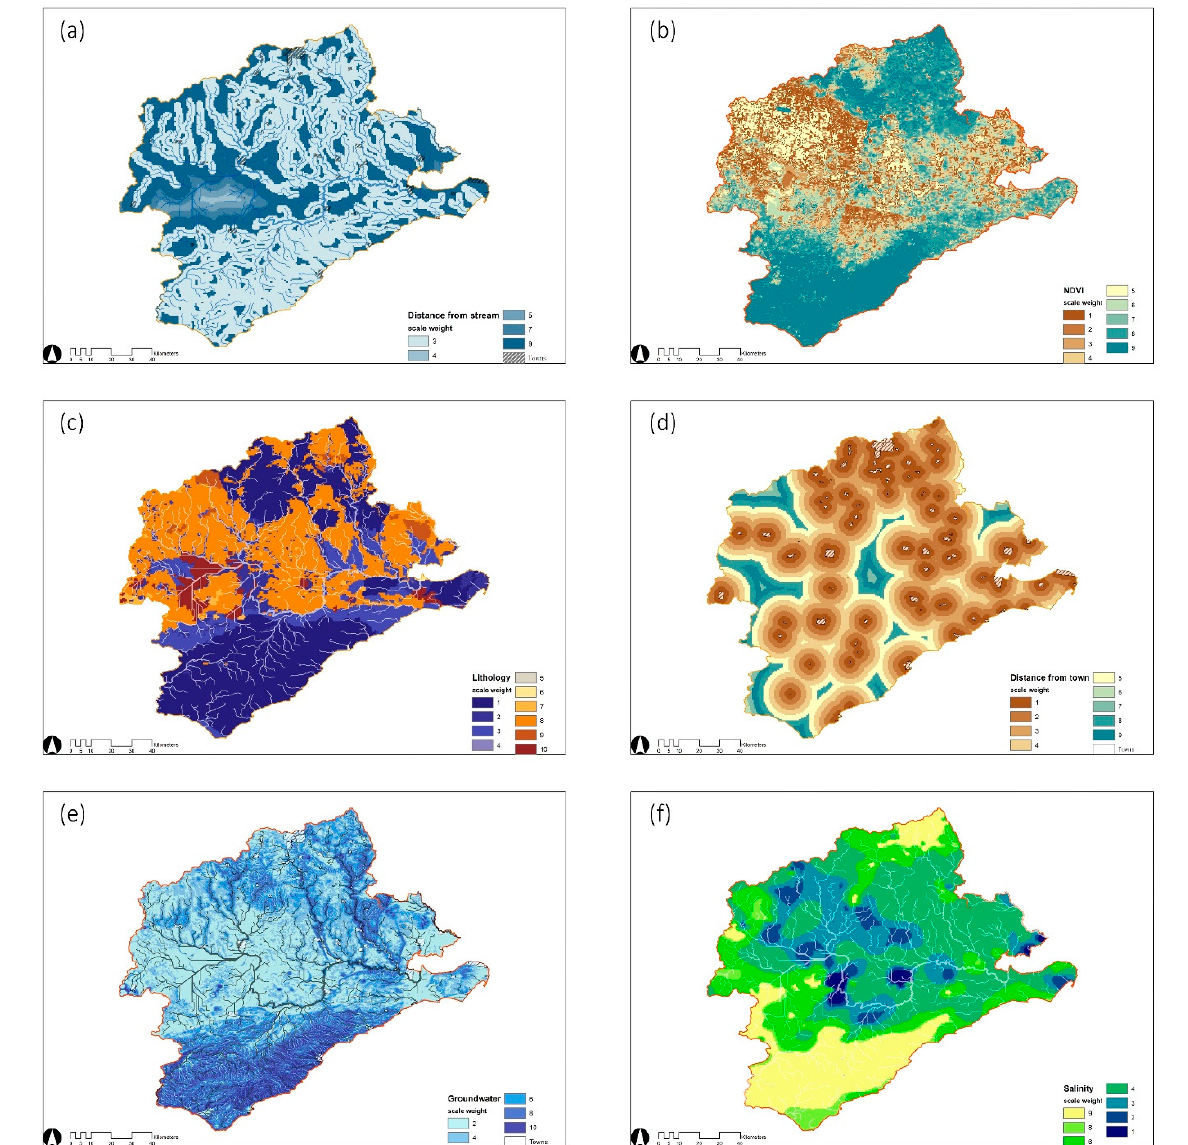
Figure 4. ( a – f ) Reclassified layers: ( a ) distance from streams; ( b ) NDVI; ( c ) lithology; ( d ) distance from towns; ( e ) groundwater; ( f ) salinity.